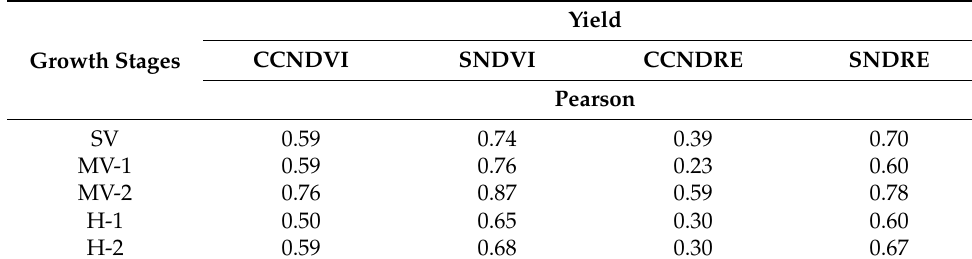
Table 5. Coefficients of determination (r 2 ) of the linear relationships of CCNDVI and SNDVI values with yield.